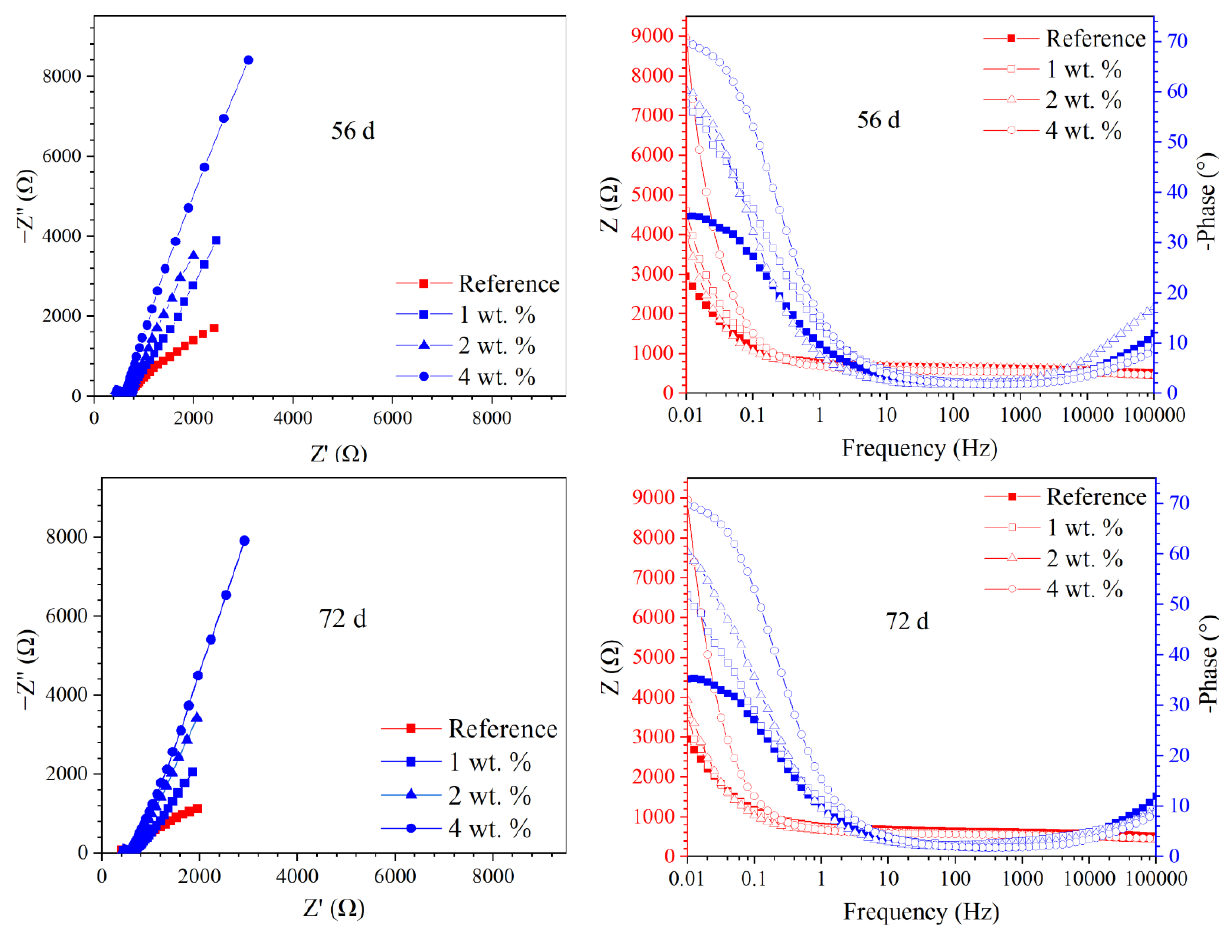
Figure 10. EIS of the reinforcement embedded in concrete immersed in 3.5 wt. % NaCl solution at different ages in both Nyquist and Bode format.